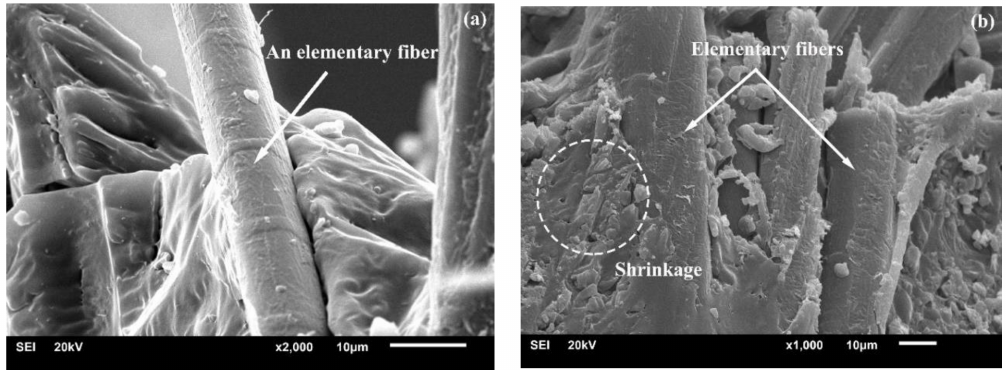
Figure 6. SEM images of tensile fracture morphology of: ( a ) UTFC; and ( b )